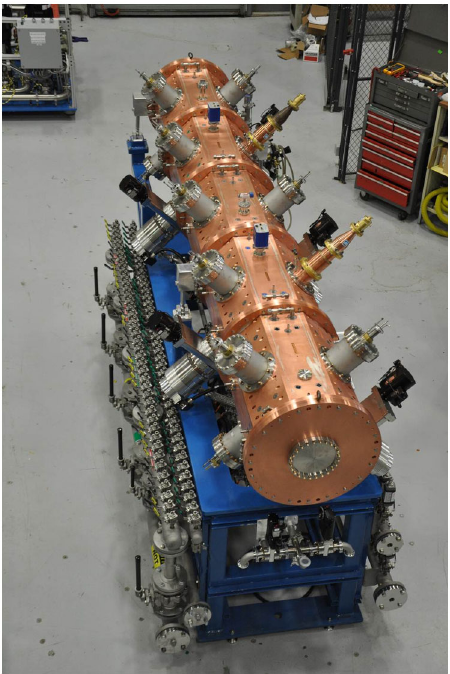
FIG. 11. RFQ assembly after installation of tuners, rf couplers, pickup loops, vacuum pumps, and vacuum